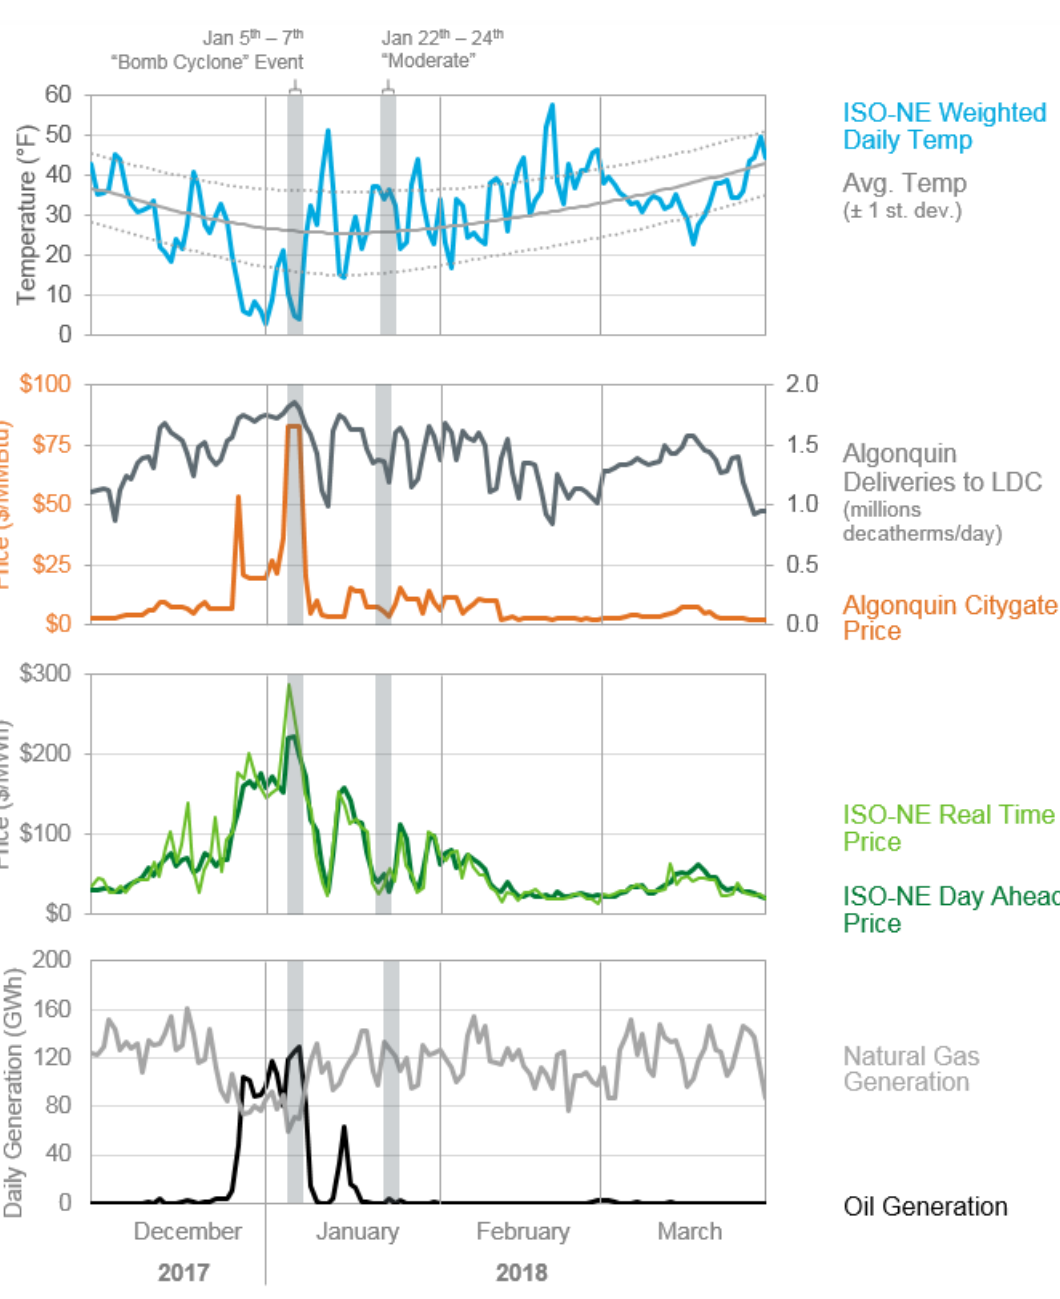
Figure 2. Summary statistics for the New England region for the winter of 2017–2018, highlighting temperatures (top panel), natural gas deliveries to local distribution companies (LDC) and prices on the Algonquin pipeline (second panel from top), daily average electricity prices in ISO-NE (third from top), and daily natural gas and oil generation (bottom). The bomb cyclone and moderate periods highlighted were selected for detailed modeling in this report. Data compiled from ISO-NE [37].